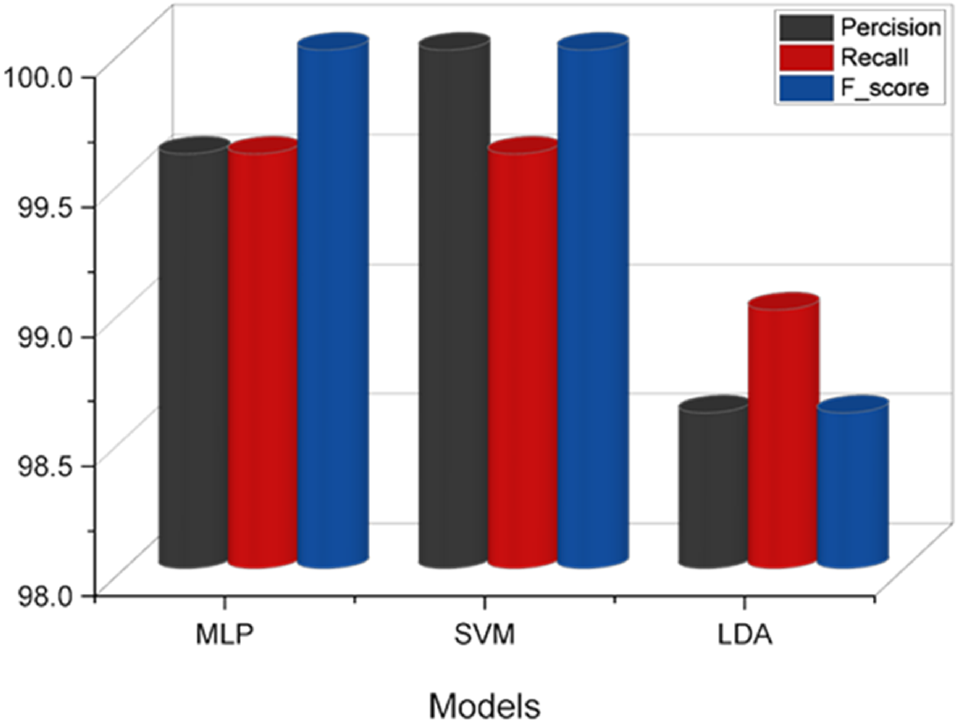
Figure 15. Average precisions, recalls, and fscores of 10-fold cross validation over training data and their standard deviation for three developed models.